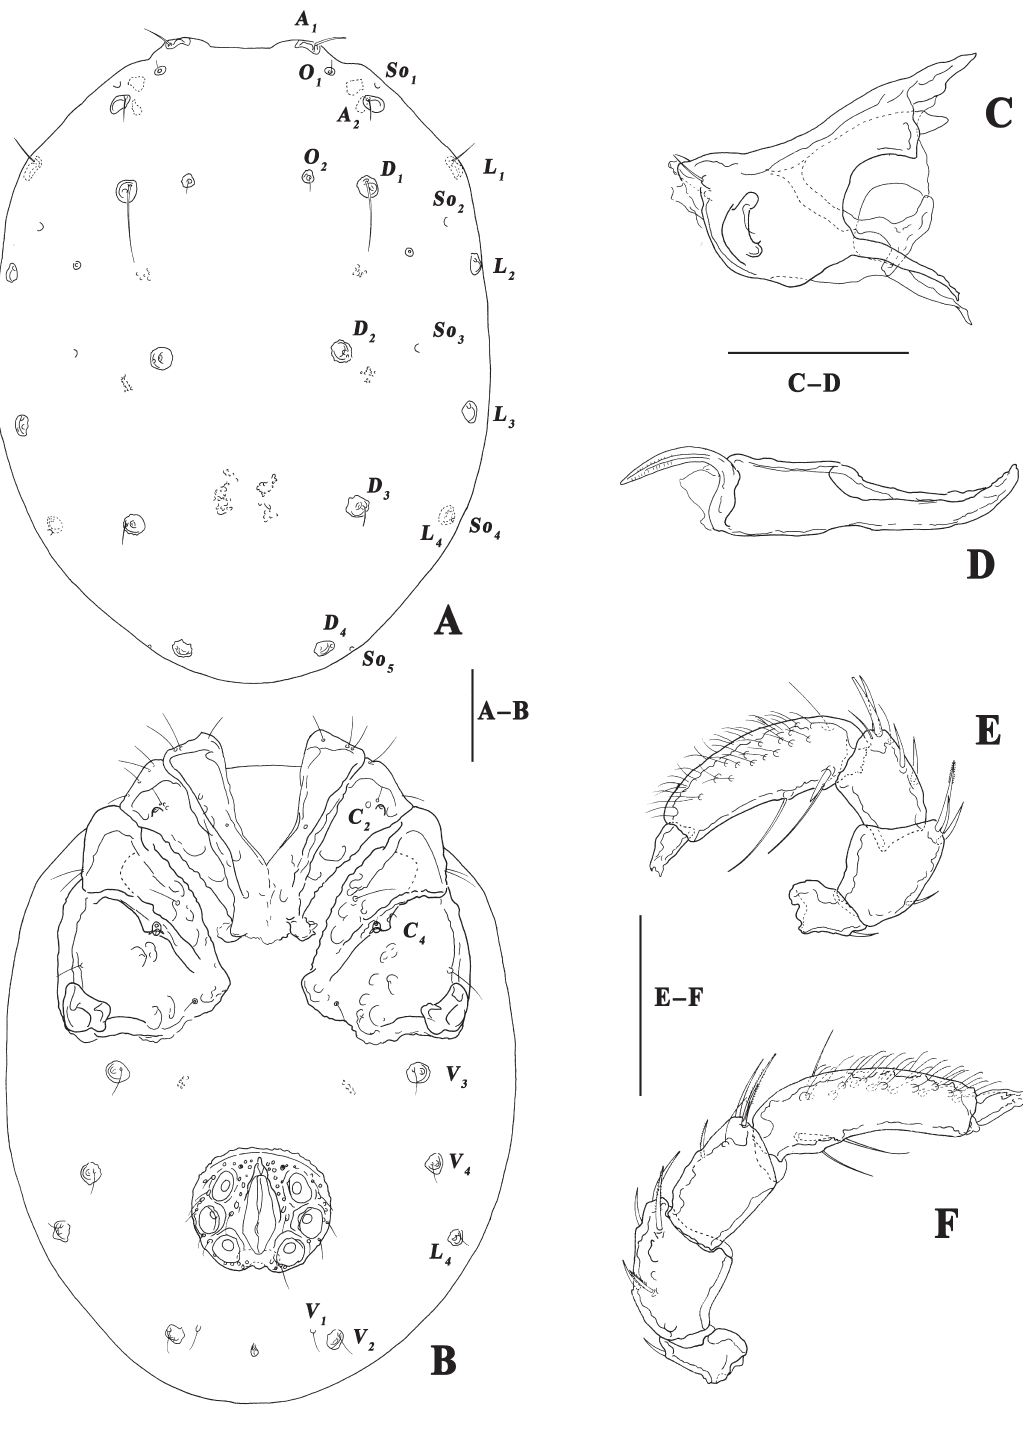
Fig. 6. Atractides ( Atractides ) menyuanensis Zhang, Li & Guo sp. nov. A–E . Holotype, ♂ ( GUGC, Slide No. QH-HY-2020072901). F . Paratype, ♀ (GUGC, Slide No. QH-HY-2020072902). A . Idiosoma, dorsal view. B . Idiosoma, ventral view. C . Gnathosoma. D . Chelicera. E . Palp. F . Palp. Scale bars = 100